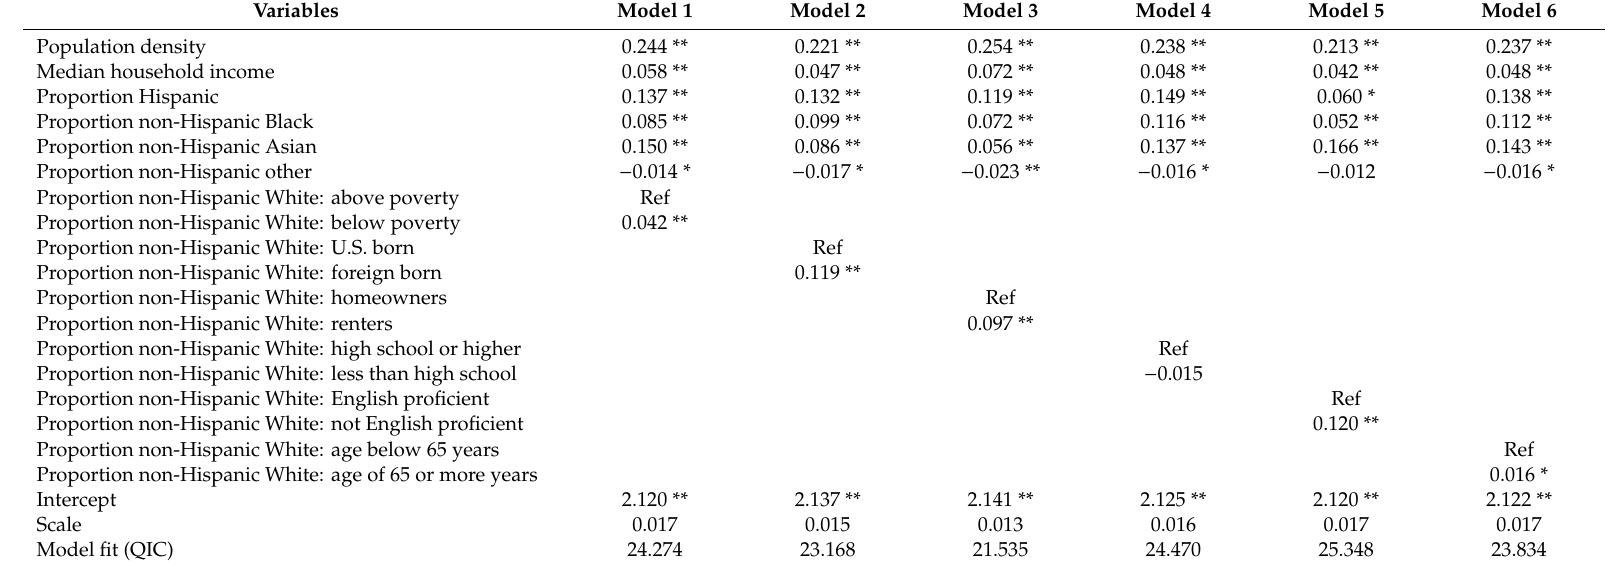
Table 6. Intra-categorical GEE analysis for the Non-Hispanic White population: Beta coe ffi